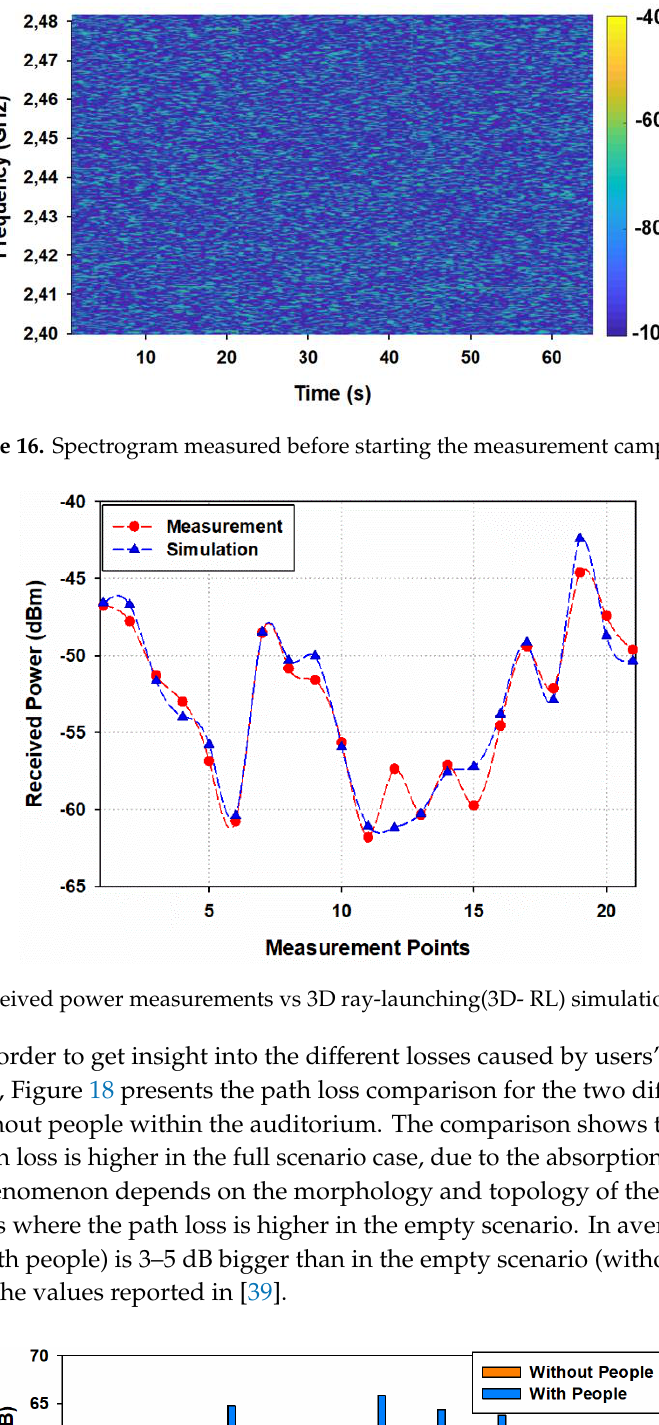
Figure 16. Spectrogram measured before starting the measurement campaign.